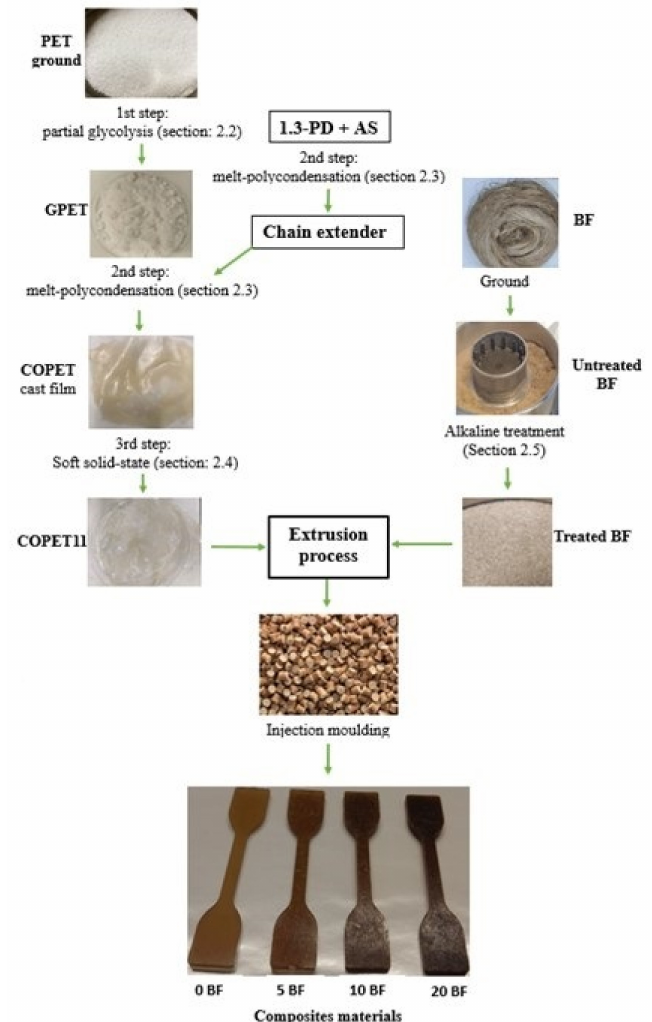
Figure 1. Schematic of PET recycling and composite processing developed in this